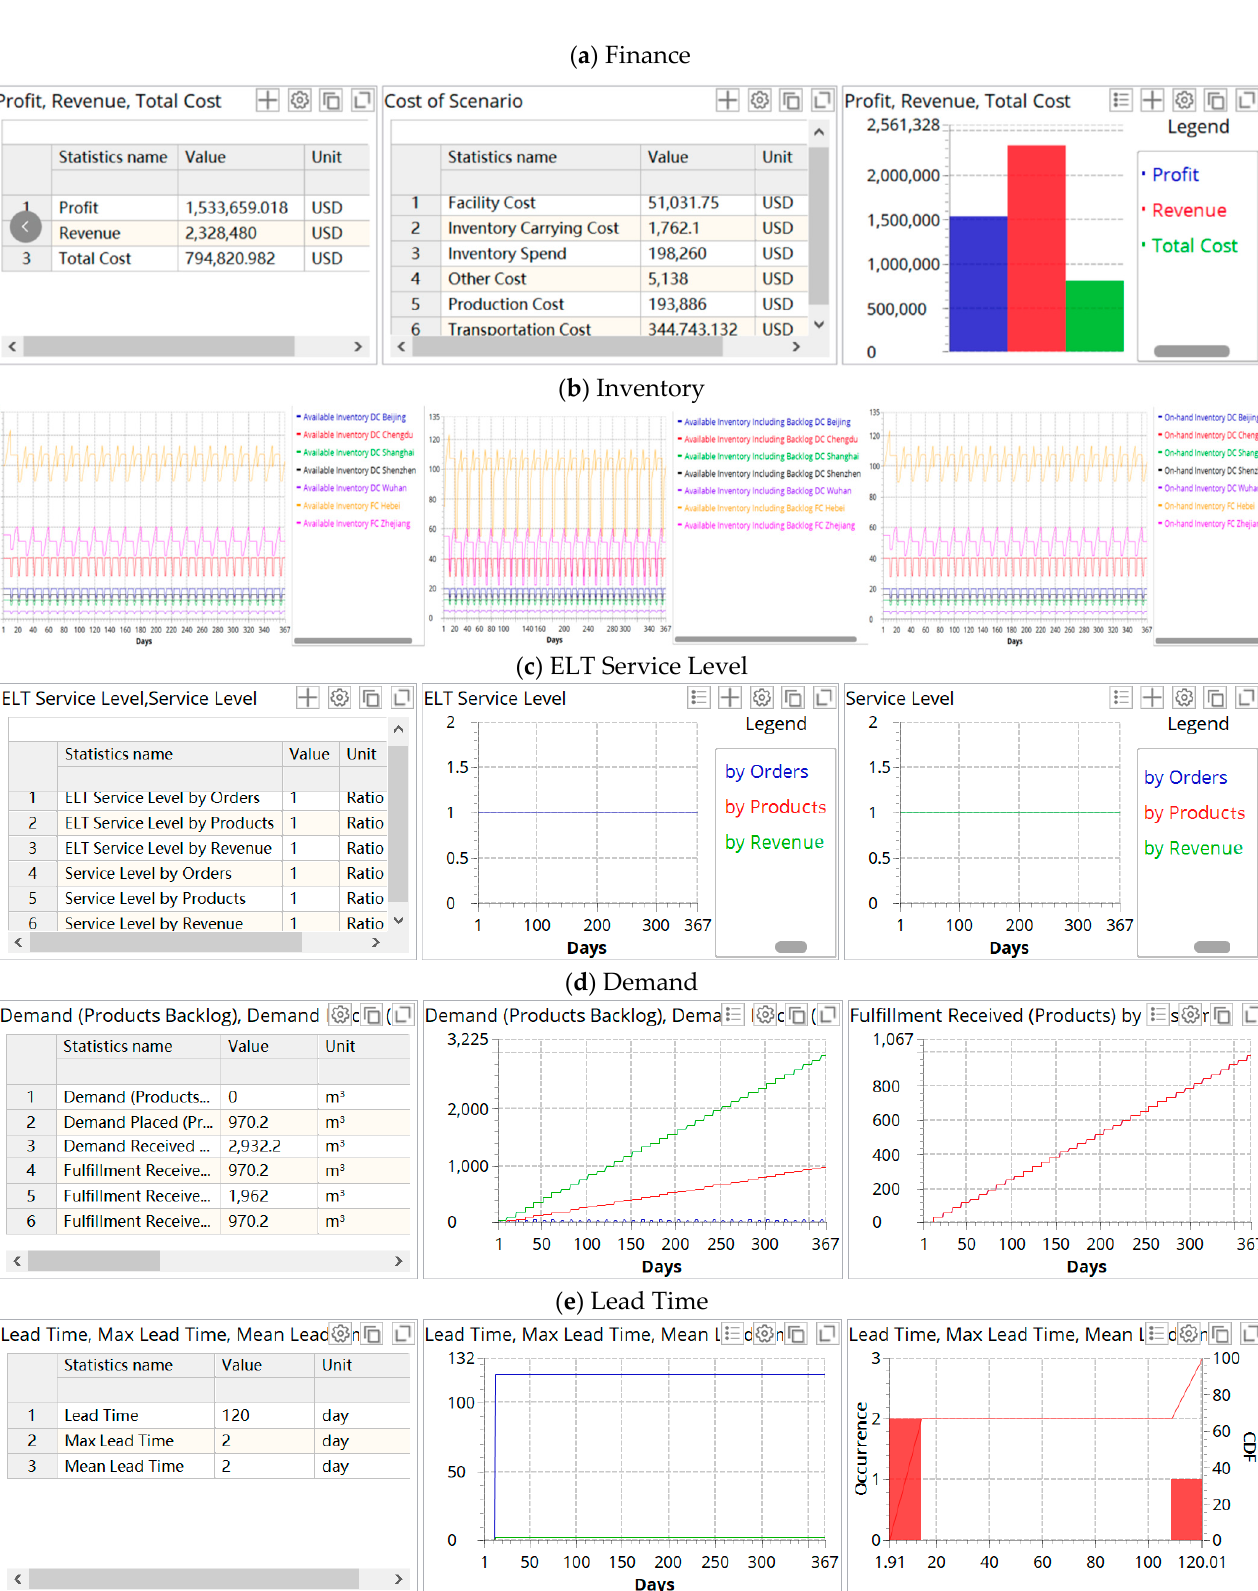
Figure 4. The supply chain performance in disruption-free scenario. ( a ) Finance; ( b ) inventory; ( c ) ELT service level; ( d ) demand, where the titles are Demand (Products Backlog), Demand Placed (Products) by Customer (left), Demand Received (Products), Fulfillment Received (Products On-time) (middle), Fulfillment Received (Products), Fulfillment Received (Products) by Customer (right); ( e ) lead time.